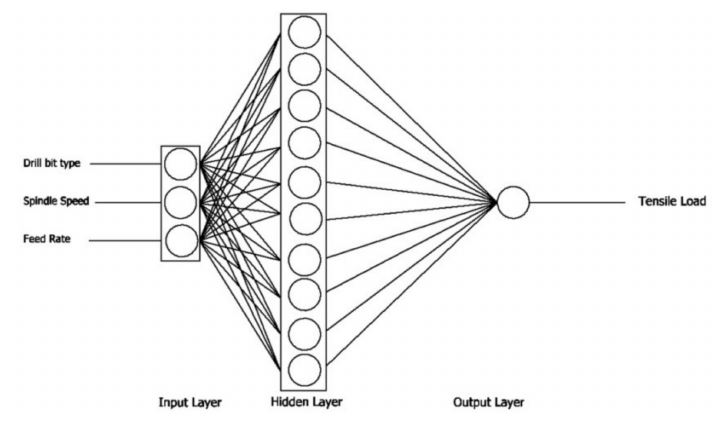
Figure 6. Artificial neural network (ANN) architecture for predict model.